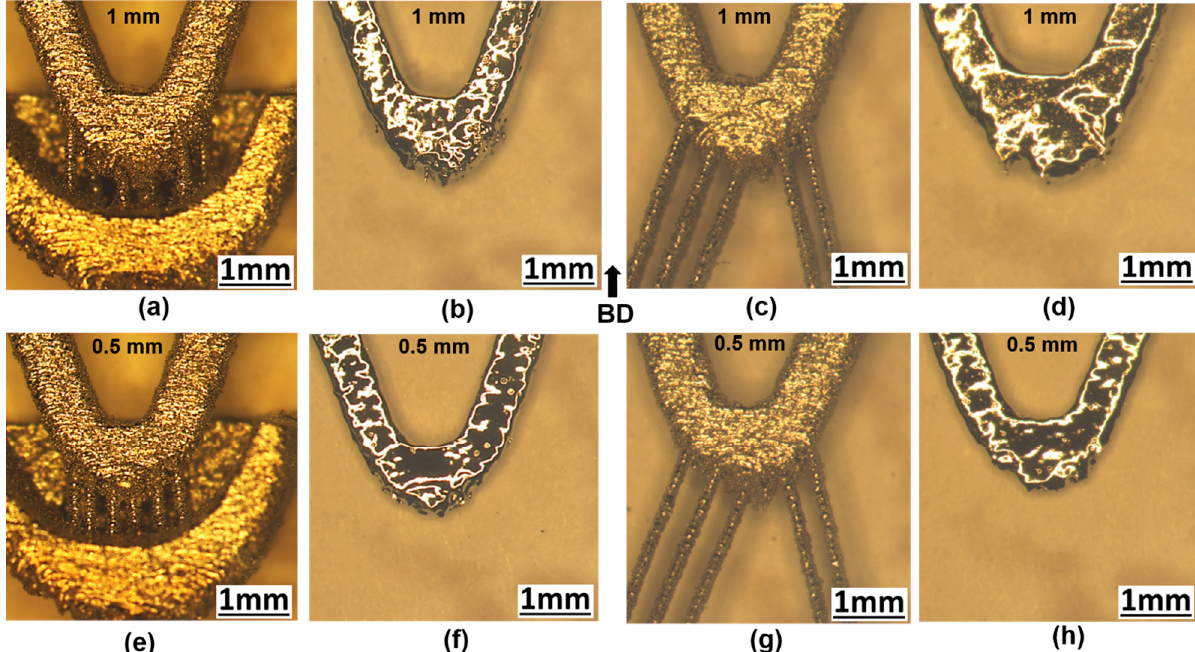
Figure 14. Light microscopy images depicting the influence of ECP on the removal of support structures manufactured using strut thickness of ( a – d ) 1 mm and ( e – h ) 0.5 mm; for strut thickness of 1 mm specimens fabricated using (a,b) cross support, ( c , d ) line support; specimens before ( a , c ) and (b,d) after ECP; for strut thickness of 0.5 mm specimens fabricated using ( e , f ) cross support, and ( g , h ) line support; ( e , g ) specimens before and ( f , h ) after ECP. Strut thicknesses are mentioned in each image.